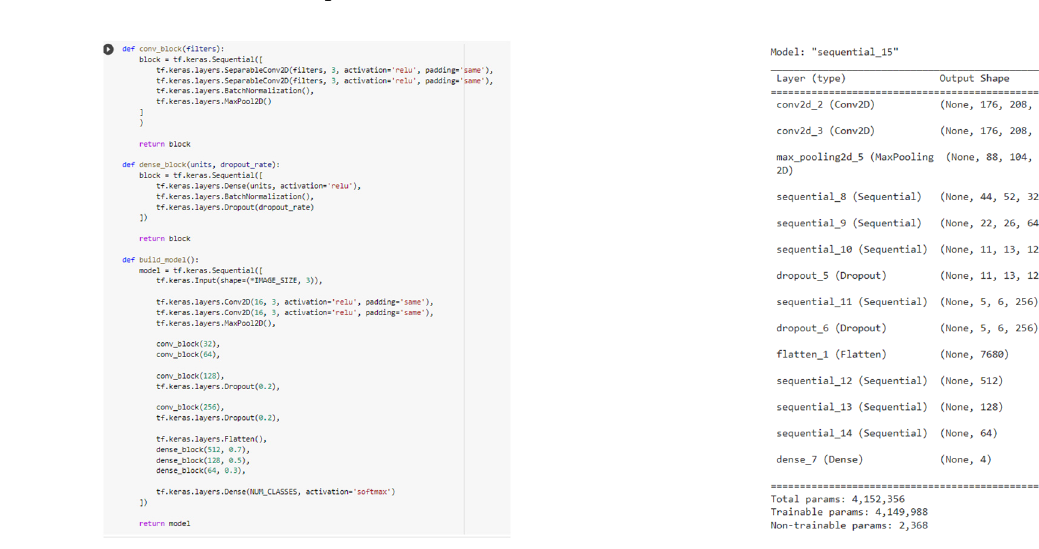
Figure A1. Tenserflow code and model configuration.